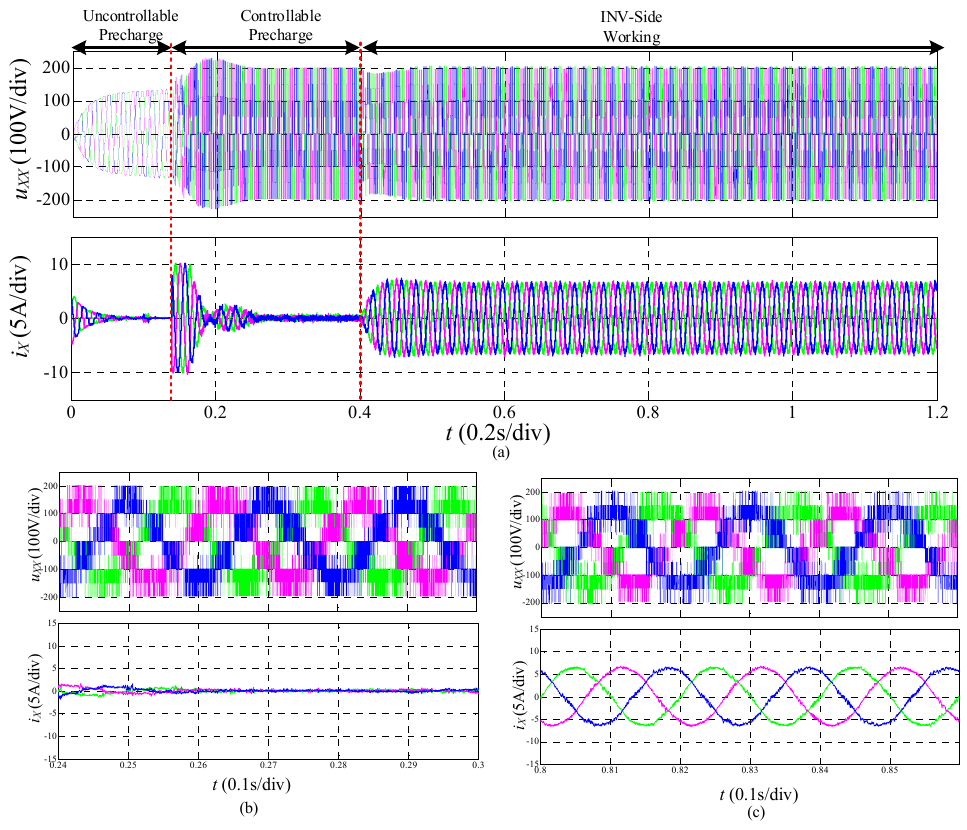
Figure 16. Simulation results of the whole working process; ( a ) Output voltage–current waveforms, u xx and i X ; ( b ) Output voltage–current waveforms, u xx and i X ; time from 0.24s to 0.3s;( c ) Output voltage–current waveforms, u xx and i X ; time from 0.8 s to 0.86 s.